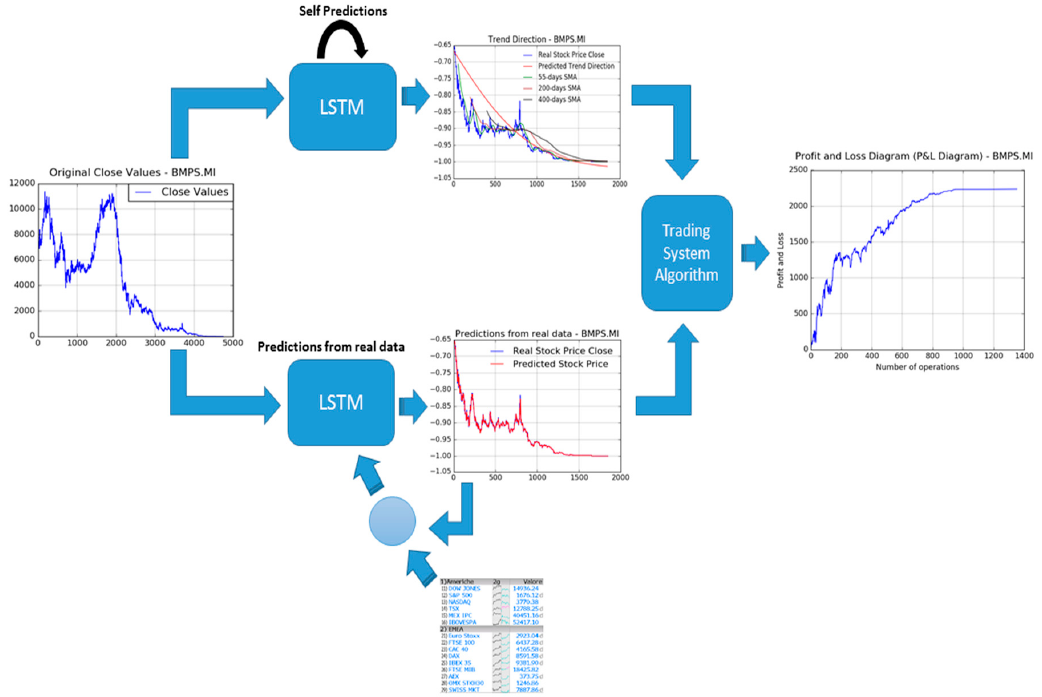
Figure 5. Overall scheme of the whole proposed financial pipeline.